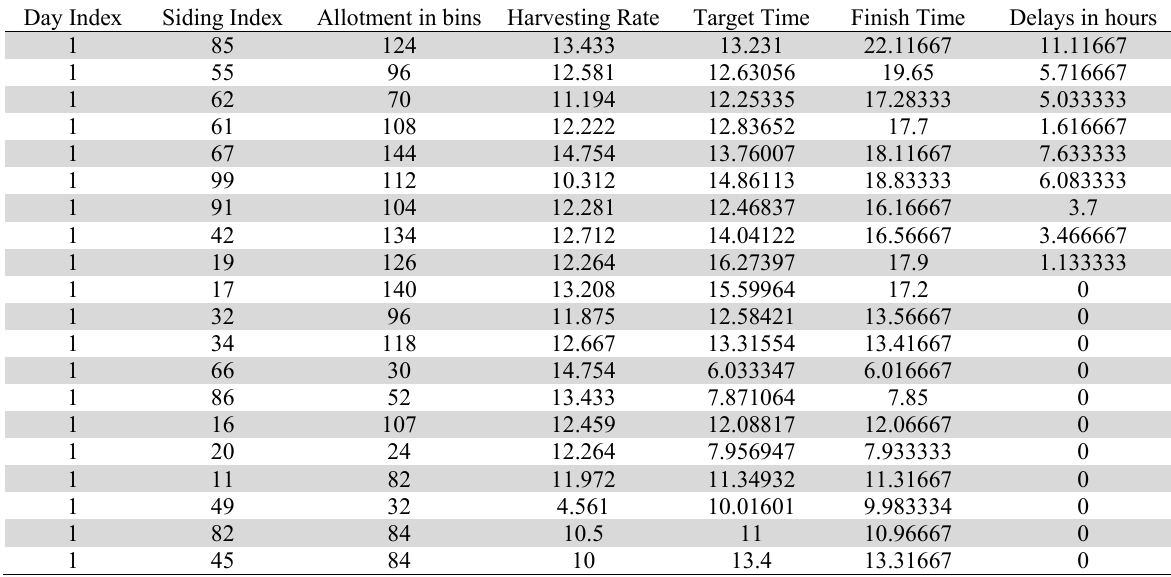
Delays of crop collections from several sidings in day 1